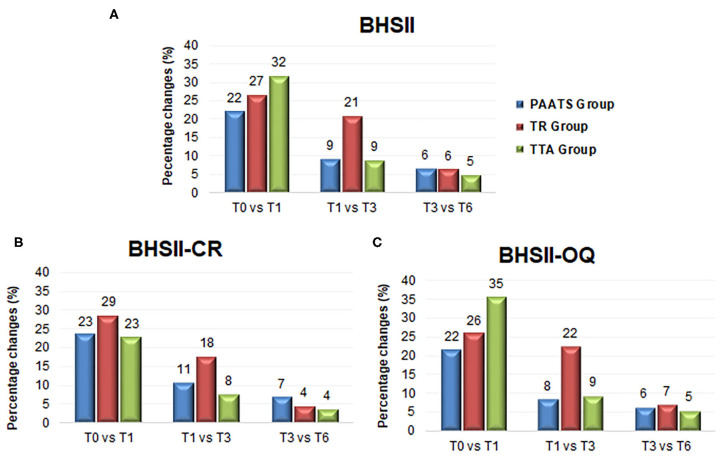
The bar charts show the percentage of change in the mean scores assessed at each time of follow-up as compared with the next time point. (A) The graph reveals the positive changes in the BHSII scores for each surgical group. (B) The graph shows the percentage of change in the Clinical Records. (C) Owner Questionnaires. T0: time before surgery, T1, T3, and T6: 1, 3, and 6 months after surgery, respectively. vs: versus. The blue bar: the group treated with the Paatsama technique, the red bar: the TightRope technique and the green bar: the tibial tuberosity advancement technique.